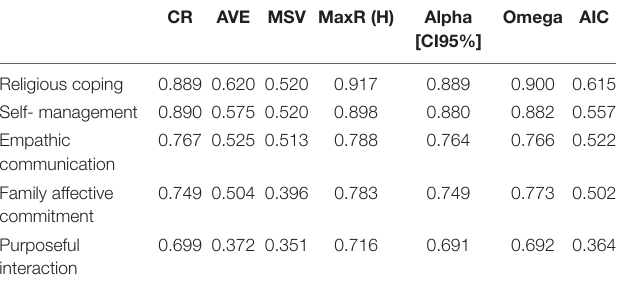
TABLE 4 | The indices of the convergent, discriminant validity, and internal consistency of FCHS OF CFA ( N =